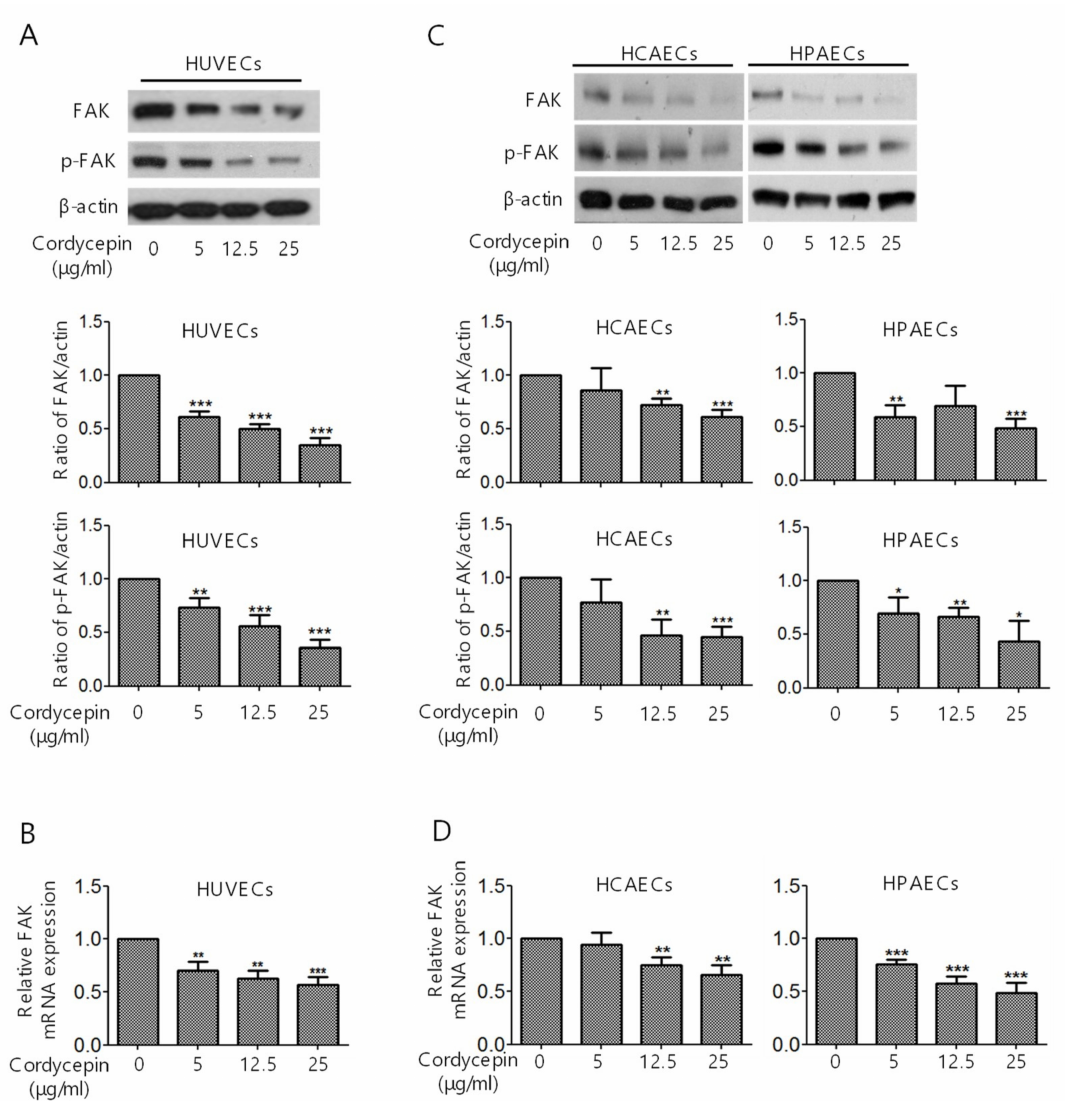
Figure 1. Suppression of focal adhesion kinase (FAK) expression and FAK phosphorylation in endothelial cells (ECs) by cordycepin. ( A,C ) HUVECs, HCAECs, and HPAECs were treated with 0–25 µ g/mL cordycepin for 24 h, and FAK and p-FAK expression levels were determined by western blotting analysis. ( B,D ) HUVECs, HCAECs, and HPAECs were treated with 0–25 µ g/mL cordycepin for 4 h, and the expression level of FAK was determined by qPCR. β -actin was used as the loading control. Scale bars: mean ± SD. * p < 0.05, **, p < 0.01; ***, p < 0.001. 2.2. Inhibition of EC Migration, Proliferation, Tube Formation, and In Vivo Angiogenesis by